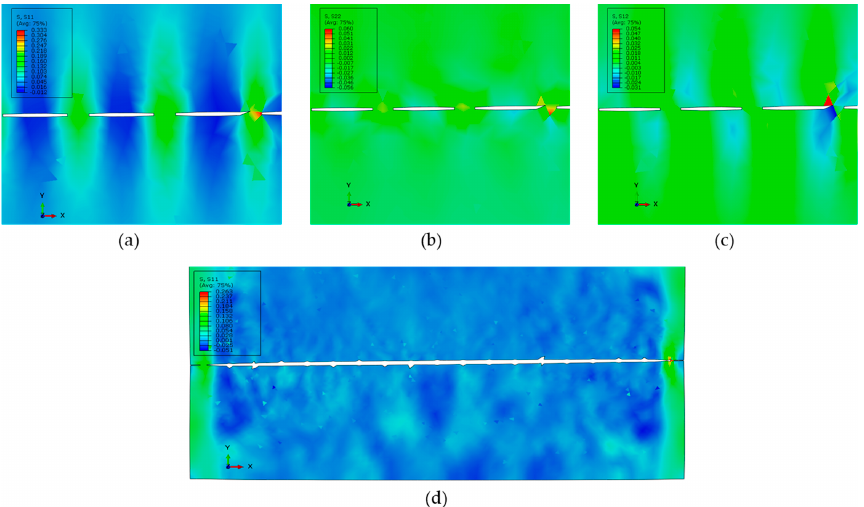
Figure 10. Stress field for the optimum orientation: ( a ) in fiber direction MD; ( b ) normal to fiber direction CD; ( c ) shear stress; ( d ) rupture for half of the model.